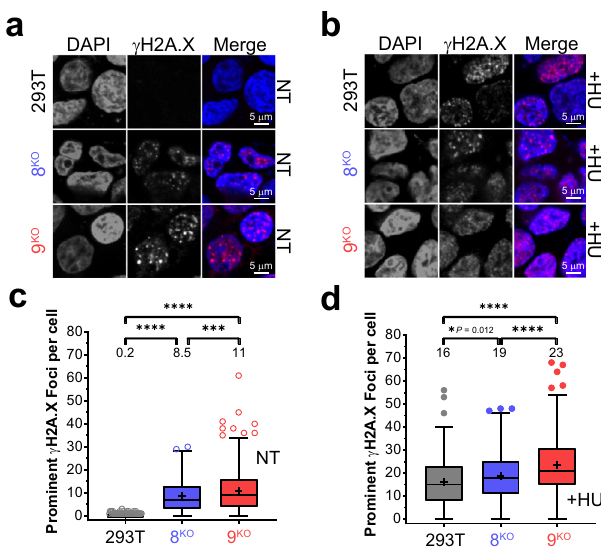
Fig. 3 | MCM8/9 protects cells from γ H2A.X markers of DNA damage during normal replication and HU-induced stalling. 293T (gray), 8 KO (blue), or 9 KO (red) were examined for either a native γ H2A.X foci in nontreated (NT) cells or b after treatment with 2mM HU for 4h (+HU) and then imaged by confocal microscopy ( n =3 independent experiments). Scale bars represent 5 µ m. Larger representative views ofmicroscopy images ofcells are shown inSupplementary Fig.8. Prominent γ H2A.X foci were quanti fi ed per cell for more than 230 nuclei using Image J and plottedasaTukeyboxandwhiskersfor c NTor d HUtreatedcells.Meanvaluesare listedabovetheplotsandwitha+embeddedinthedata.Boxboundariesrepresent the 1st and3rd interquartile range (IQR);the line represents the median; the upper andlowerwhiskersaredesignatedatadatapoint ≤ (±1.5×IQR);and individualdata pointsoutsidethewhiskersareshown.AMann – Whitneytwo-sidedUtestwasused to calculate P values (* P <0.05, *** P <0.001, **** P